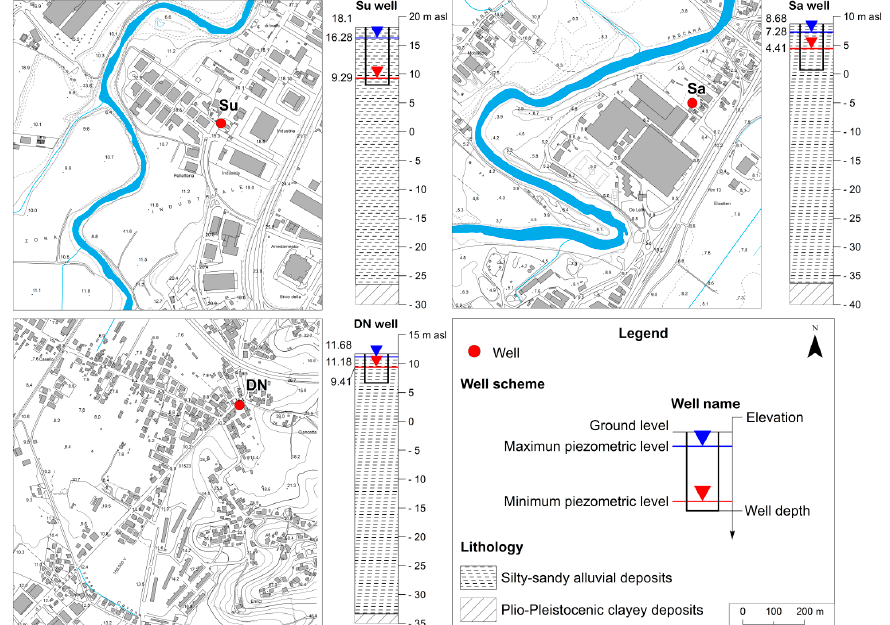
Figure 4. Locations, stratigraphy and piezometric levels or the assessed wells.